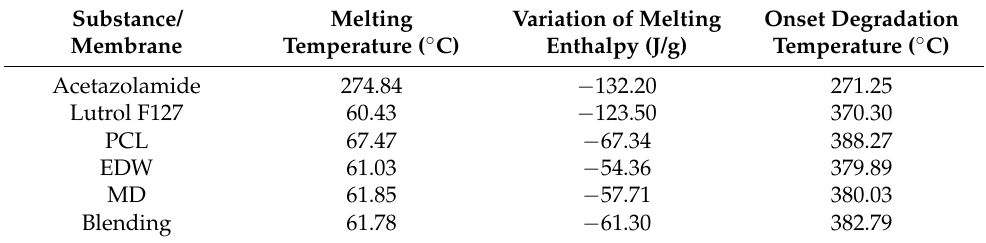
Table 8. Melting temperature, onset degradation temperature and variation of melting enthalpy of pure substances: acetazolamide, Lutrol F127, PCL and the membrane formulations: EDW, MD and